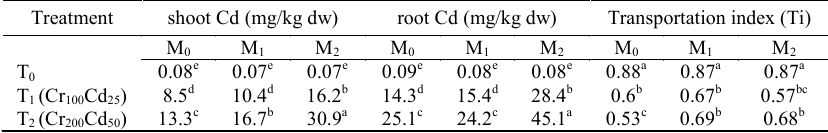
Table 3: Effect of application of heavy metals and type of organic substances in concentration and transportation index of Cd in maize plant (shoot and root) Treatment shoot Cd (mg/kg dw) root Cd (mg/kg dw)